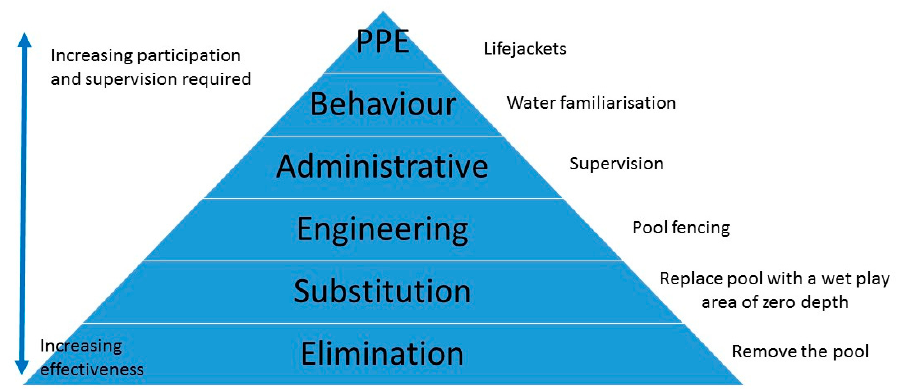
Figure 1. The Hierarchy of Controls and swimming pool safety.